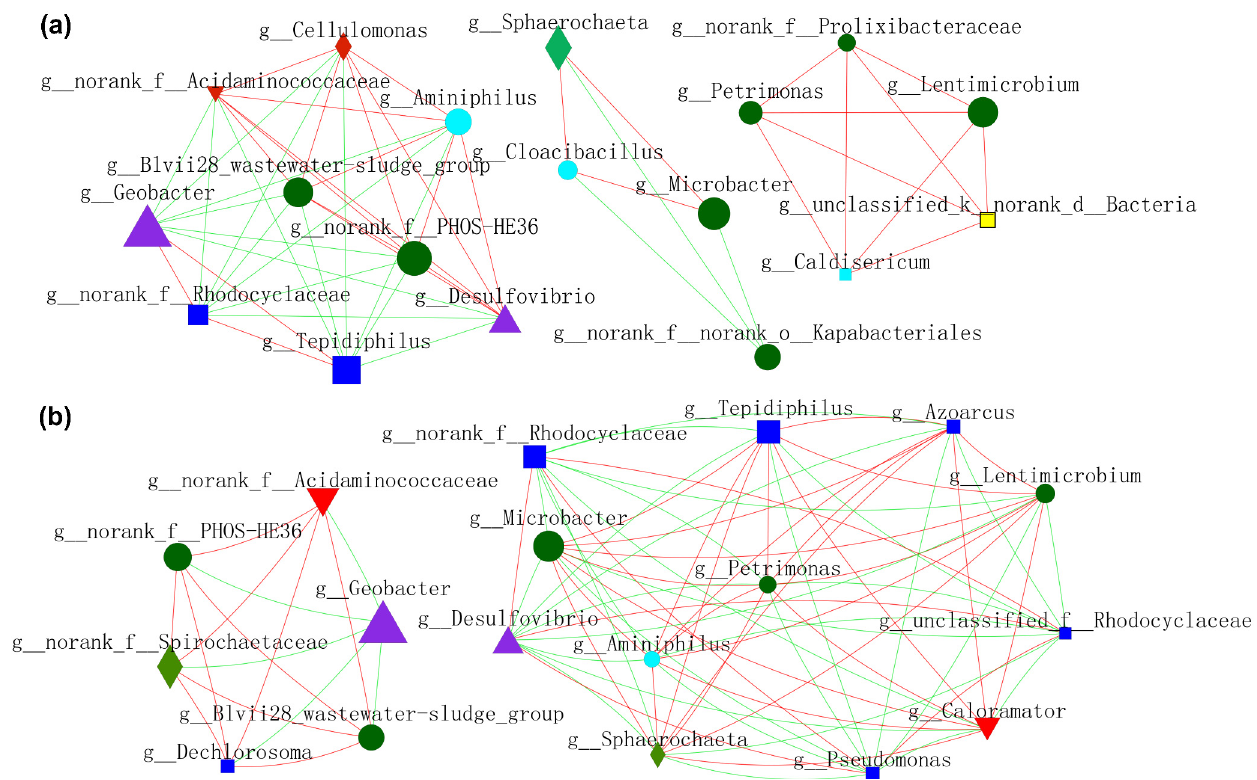
Figure 9. Molecular ecological networks (MEN) visualization of electroactive consortia in MFCs. ( a ) shows microbes resided in anode biofilm mediated by S-doped nanomaterials. ( b ) shows microbes resided in biofilm of CC anode in Group 2, Group 3 and Group 4. Different colors and shapes of nodes signifier categories of phylum: Proteobacteria (deep blue diamond), Bacteroidota (deep green round), Desulfobacterota (purple triangle), Synergistota (sky blue round), Unclassified phylum (yellow diamond, Firmicutes (red diamond), Actinobacteriota (red inverted triangle), Spirochaetota (light green diamond). A red edge indicates a positive interaction between two individual nodes, while a green edge indicates a negative interaction.